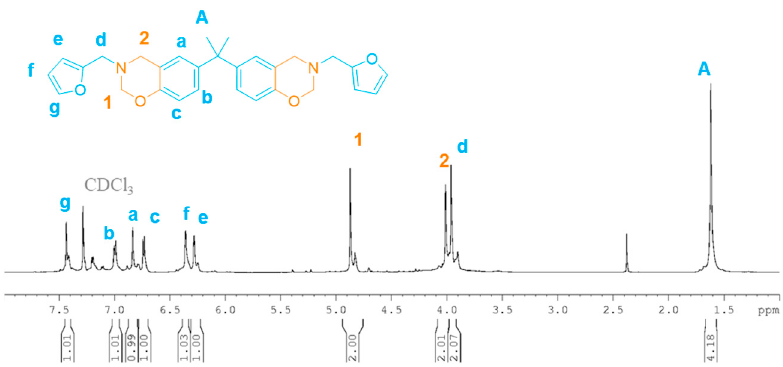
Figure A33. 1 H NMR spectrum in CDCl 3 of BA-fa.